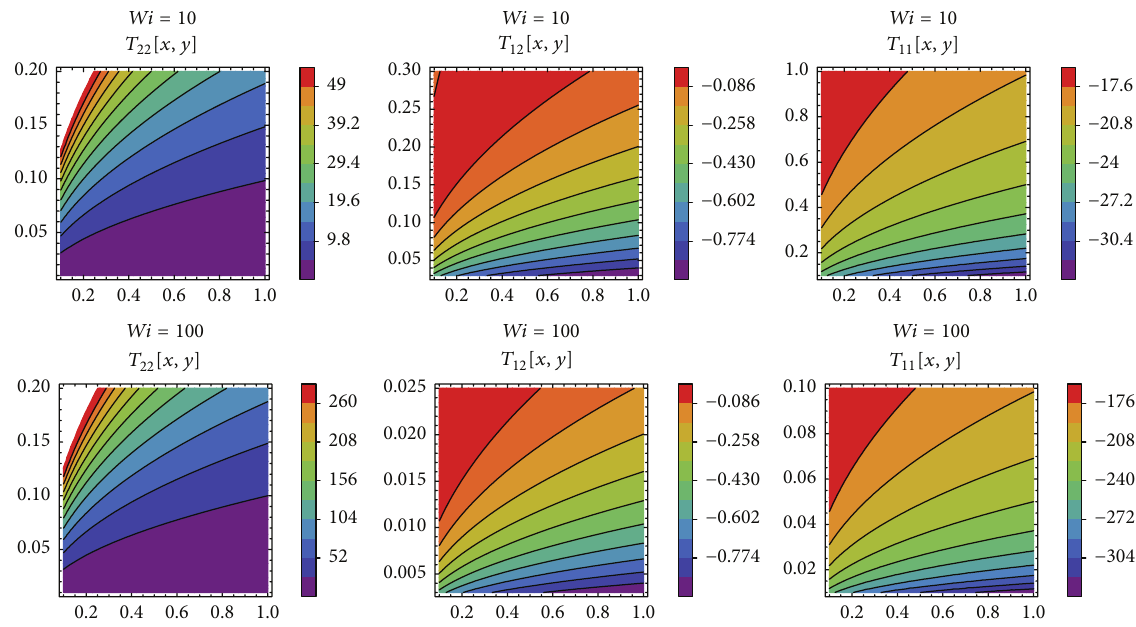
Figure 6: Dimensionless stress components on a stretching plate in the 𝑥 - 𝑦 plane: for 𝐶 = −0.5 for 𝑊𝑖 = 10 and